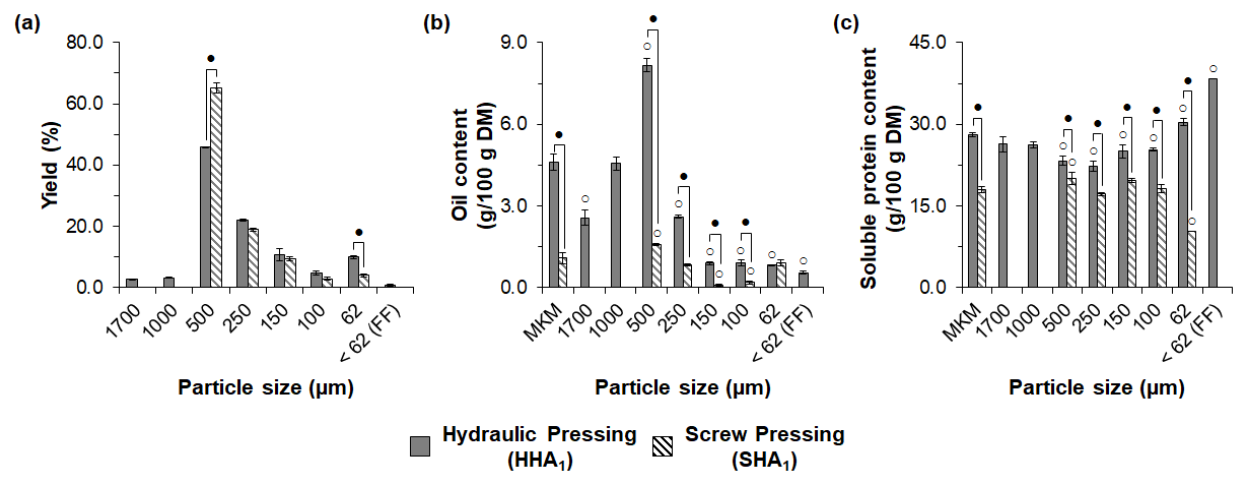
Figure 3. Influence of pressing method on exploratory sieve fractionation of macauba kernel meals after milling to 1 mm and hexane extraction: ( a ) yields, ( b ) oil content, and ( c ) soluble protein content of the sieved fractions. MKM: macauba kernel meal; FF: fine fraction. White circles indicate significant differences ( p < 0.05) in relation to the respective MKMs. Dark circles indicate significant differences ( p < 0.05) between fractions of the same particle sizes and different pressing methods.